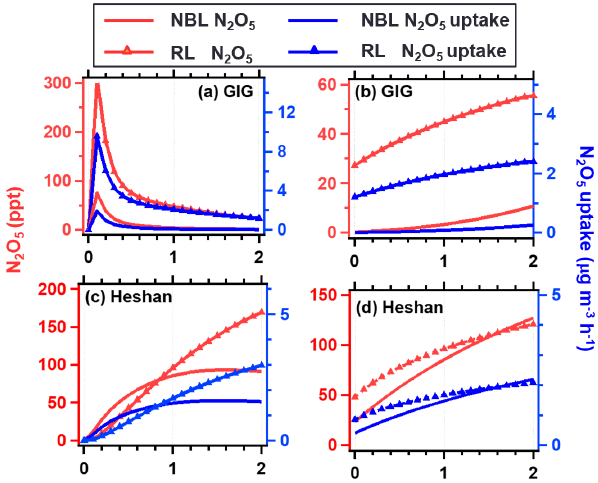
Figure 13. Simulated average concentration of N 2 O 5 and nitrate production rate from N 2 O 5 uptake with the normalized changes of NO x and AVOC emissions at the (a, b) GIG site and (c, d) Heshan site in the NBL and